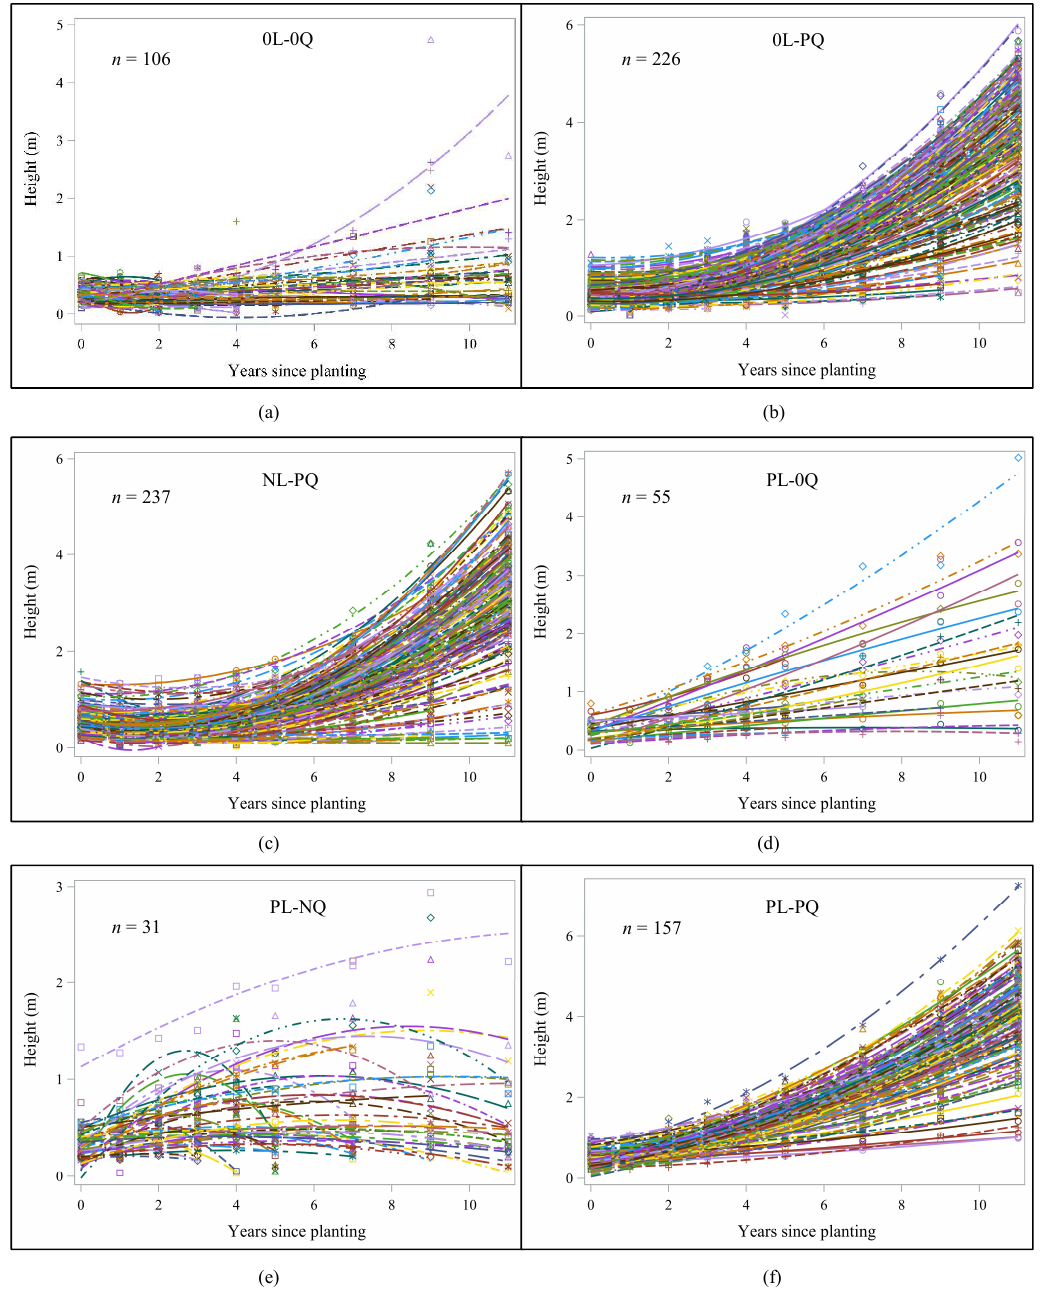
Figure 4. Linear (L) and quadratic (Q) terms were fit into regression models predicting growth patterns for each seedling. Each term was either not significant (0), or showed a positive (P) or negative (N) trend. Each seedling is represented by a single line within one of six growth patterns. ( a ) neither the linear nor quadratic terms were significant; seedlings grew nominally; ( b ) only the quadratic term was significant; seedlings grew slowly and then more rapidly over time; ( c ) negative linear and positive quadratic terms; seedlings experienced die-back before adding growth; ( d ) positive linear and no quadratic terms; seedlings grew linearly; ( e ) positive linear and negative quadratic terms; seedlings grew and then died-back; and ( f ) positive linear and quadratic terms; seedlings grew progressively more rapidly over